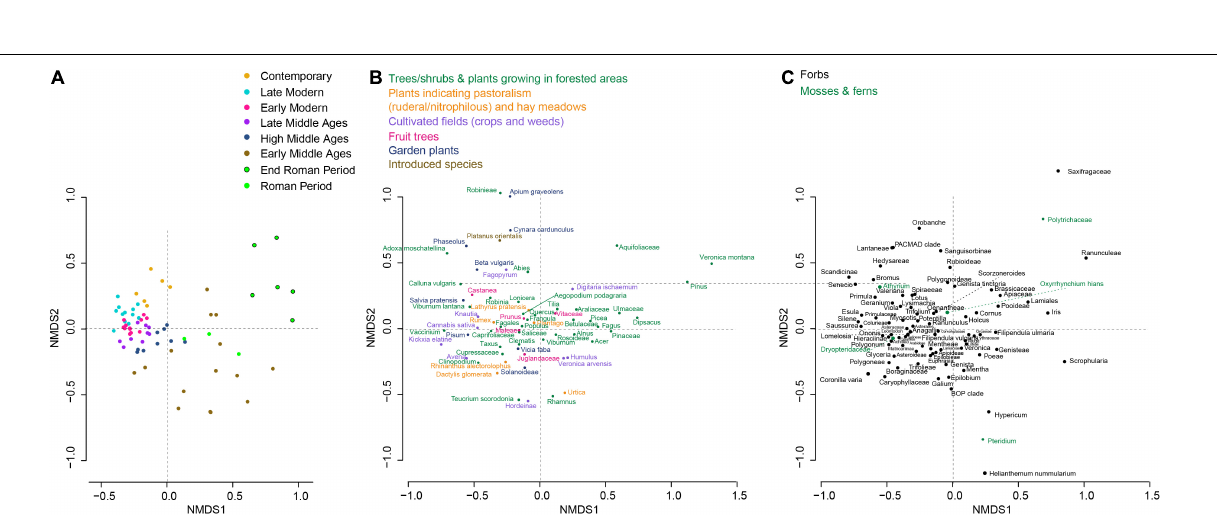
FIGURE 7 | Temporal trajectory of plant composition as revealed by a non-metric multidimensional scaling (NMDS) analysis from lake sedaDNA data (stress value = 0.14). (A) Sample (each replicates) distribution in the NMDS plot. The color code represents the different cultural periods. (B) Distribution of taxa related to (or potentially related to) human activities in the NMDS plot. (C) Distribution of all other taxa in the NMDS plot.